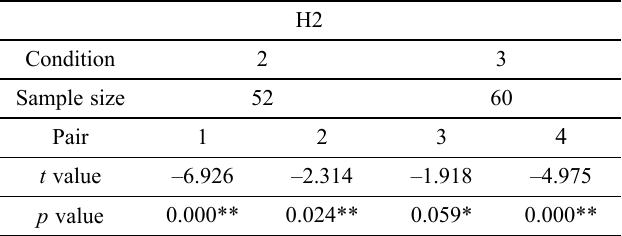
Table 3. Results for hypothesis